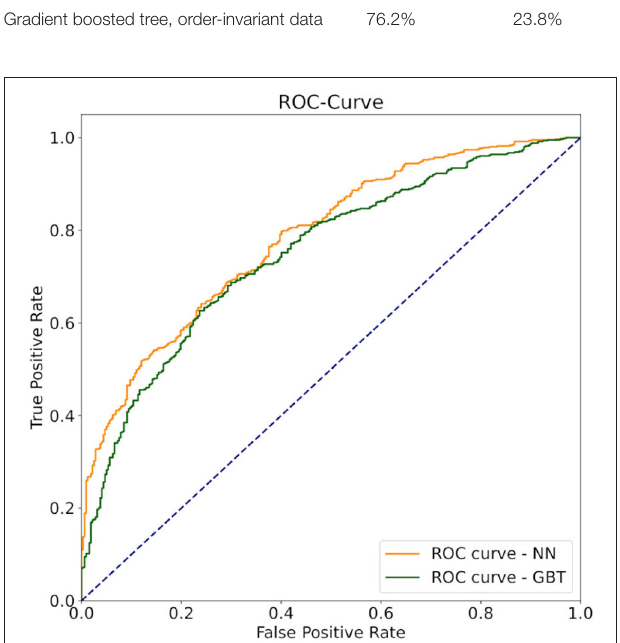
FIGURE 5 | The ROC curve of the pass completion probability model. The AUROC is 0.746 for the neural network and 0.730 for the gradient boosted tree. The dashed blue line, represents the baseline of a random sample, the orange line, the ROC curve of the neural network, and the green line represents the ROC curve of the gradient boosted